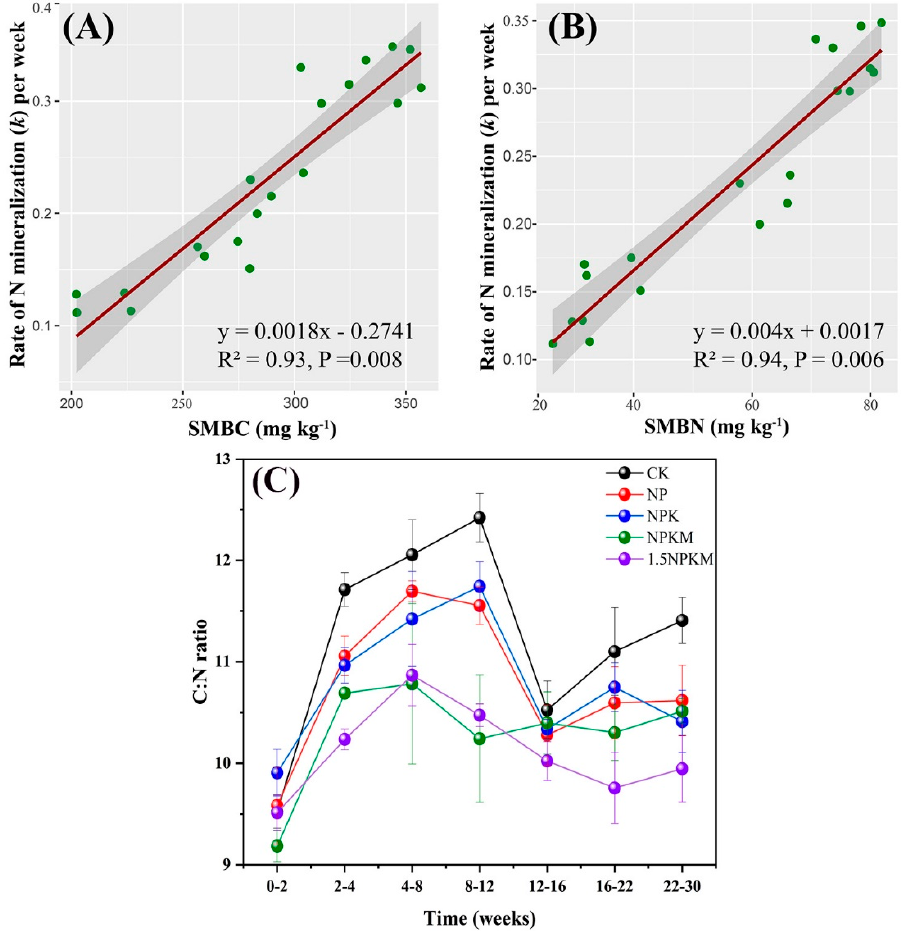
Figure 5. Relationship between N mineralization rate (constant) and soil microbial biomass carbon ( A ), Nitrogen ( B ), and changes in the C/N ratio among the treatments in relation to time ( C ).